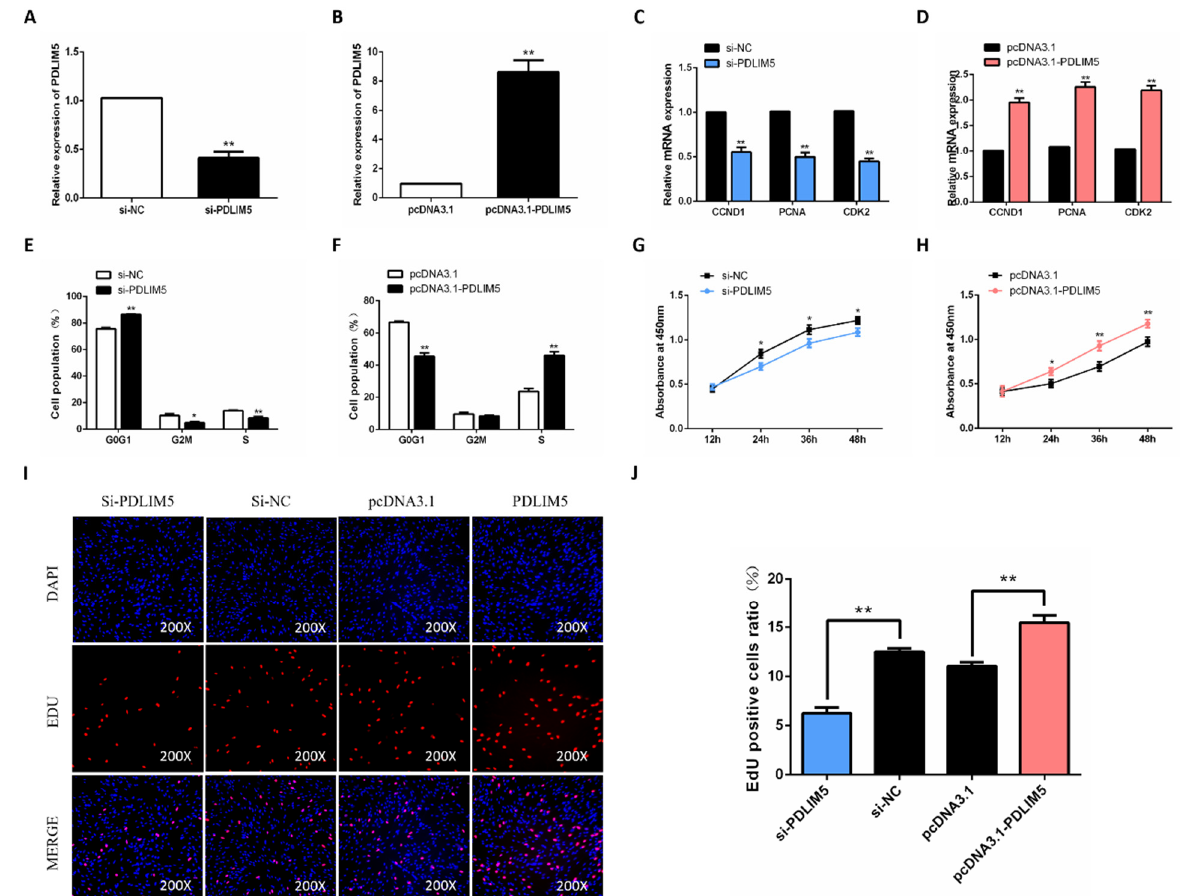
Figure 2. PDLIM5 increased proliferation of chicken SMSCs. The mRNA expression of PDLIM5 in cells that transfected with si-RNA ( A ) or plasmid ( B ). After 48 h of PDLIM5 inhibition ( C ) or overexpression ( D ), qPCR was used to detect SMSC proliferation-related genes. Cell cycle analysis of SMSCs after inhibition ( E ) or overexpression ( F ) of PDLIM5 for 48 h. ( G , H ) After overexpressing PDLIM5 or inhibiting PDLIM5 in SMSCs, the cell proliferation activity was measured using CCK-8 kit. ( I , J ) The EdU fluorescence (red) was considered the proliferation indicator, and the cell nuclei were represented by DAPI (4’,6-diamidino-2-phenylindole, blue) fluorescence. The ratio of EdU-positive cells was determined when PDLIM5 was overexpressed or inhibited. * p < 0.05; ** p < 0.01 vs. NC and pcDNA3.1 (negative control). ( n = 9).